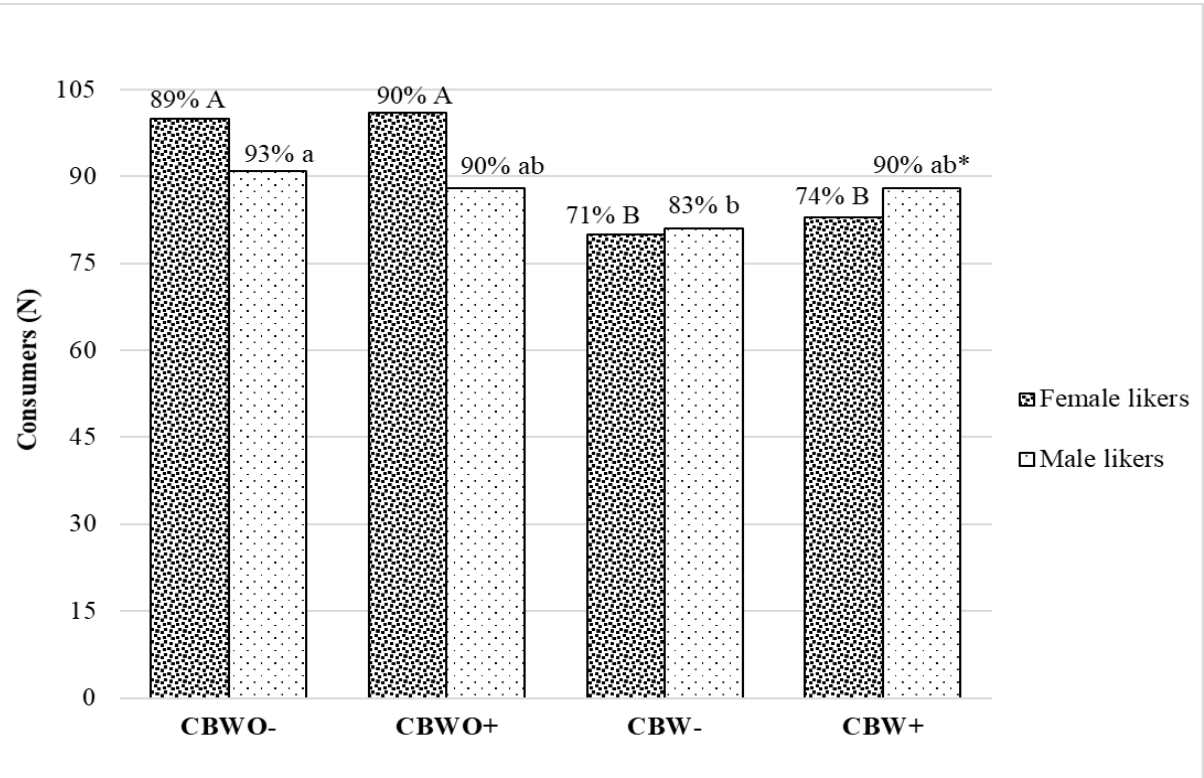
Figure 4. Likers and dislikers gender frequency plot across treatments † . Data are frequencies of n = 112 female and n = 98 male consumers analyzed by Cochran’s Q test with asymptotic McNemar test for post hoc multiple pairwise comparisons and p -value adjustment by false discovery rate. Liking clusters were determined through agglomerative clustering analysis from actual hedonic attributes rating applying Euclidean-distance dissimilarity, Ward's agglomeration method, and average silhouette width to determine the ideal number of clusters. † Treatments are described in Figure 1. Uppercase/lowercase letters represent a significant ( p < 0.05) difference in the proportion of “likers” across treatments within female/male consumers. * Significant ( p < 0.05) difference in “likers” proportion across genders (Z-test 2 population proportions).